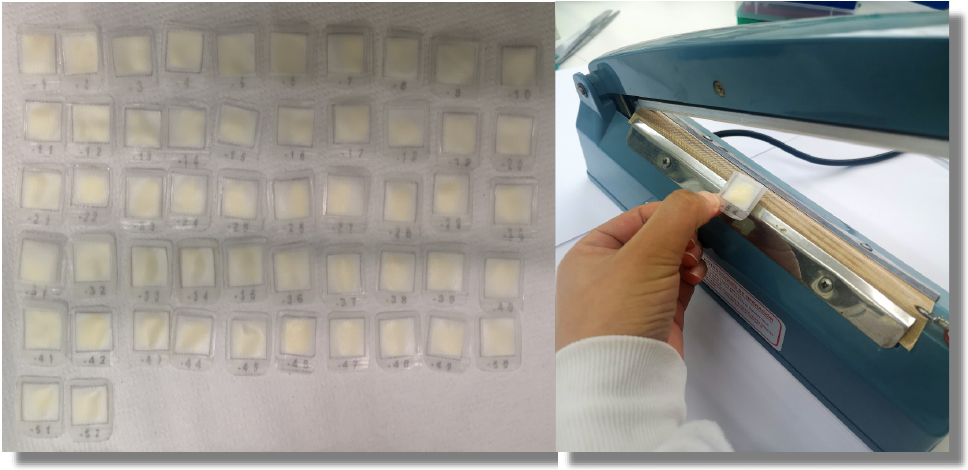
Figure 2. Preparation and sealing of the tea